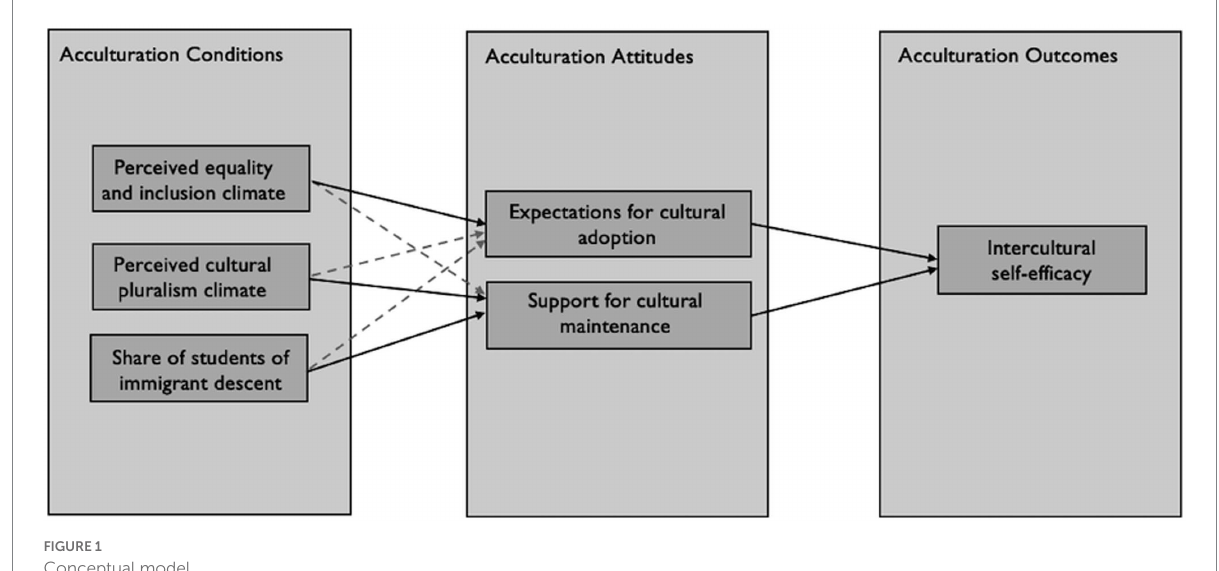
FIGURE 1 Conceptual